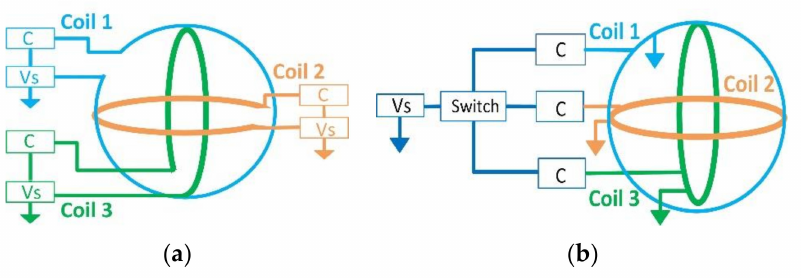
Figure 4. Multicoil anchor Tx and sensor Rx node configuration setups. ( a ): TD coil design, in which each of the three coil is coupled to an independent current source. ( b ): TD coil design, in which a switch connects each of the three coil to a single current source.